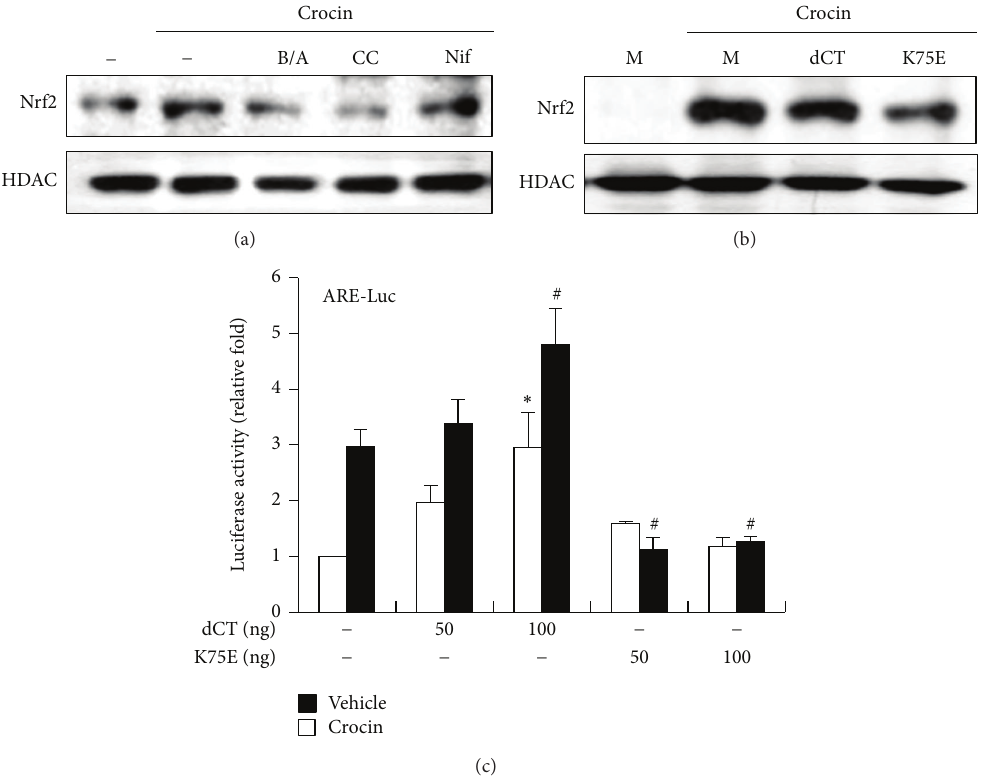
Figure 7: Regulation of Nrf2 activation by CAMK4. (a) RAW 264.7 cells were incubated with BAPTA/AM (B/A, 5 𝜇 M), calmidazolium chloride (CC, 5 𝜇 M), and nifedipine (Nif, 5 𝜇 M) for 1h and then treated with crocin (500 𝜇 M) for 3h. Equal amounts of nuclear proteins were subsequently analyzed by Western blotting. (b) Cells were transfected with pcDNA3.1 (mock, M), CAMK4 constitutive active (dCT), or kinase dead (K75E) construct and then treated with crocin (500 𝜇 M). Equal amounts of nuclear proteins were then analyzed by Western blotting. HDAC was used as a loading control. (c) Cells were cotransfected with ARE-luciferase construct and pcDNA3.1, dCT, or K75E and then treated with crocin (500 𝜇 M). Equal amounts of cell extracts were assayed for dual luciferase activity. ∗ 𝑃 < 0.05 versus the pcDNA3.1- transfected (vehicle-treated) group; # 𝑃 < 0.05 versus the pcDNA3.1-transfected (crocin-treated)